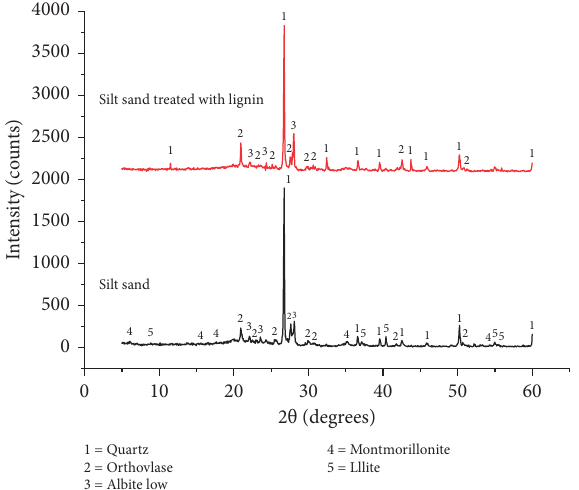
Figure 14: XRD analysis of silt sand and silt sand treated with lignin.